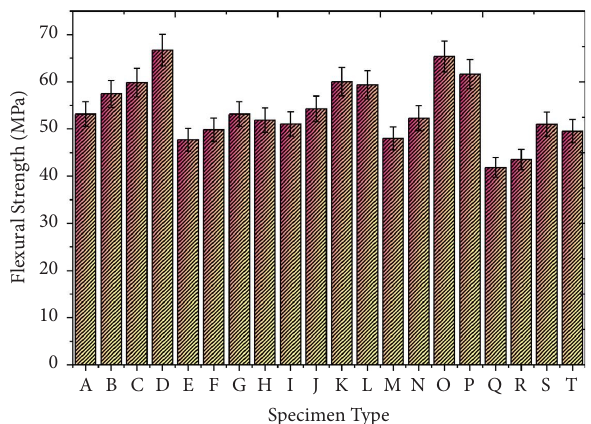
Figure 8: ILSS behaviour of biosynthesised Al 2 O 3 /jute/hemp/ oxy hybrid composites.